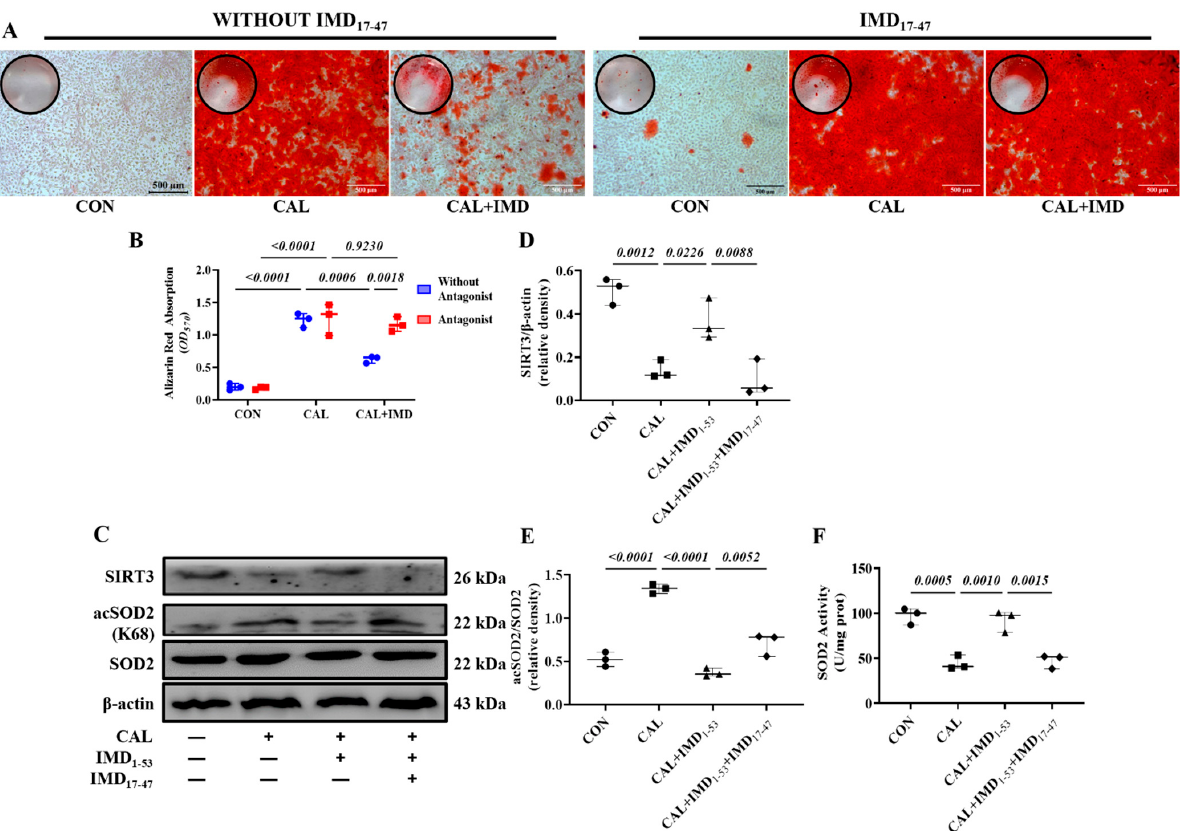
Figure 6. IMD upregulated Sirt3 via its receptor complex. ( A ) Alizarin red staining (positive staining: red) of rat VSMCs (Scale bar = 500 µ m), and ( B ) quantification ( n = 3). ( C ) Western blot analysis of protein levels of Sirt3, acetylation-SOD2 (K68) and SOD2 in rat VSMCs and quantification of ( D ) Sirt3 and ( E ) acetylation-SOD2 to SOD2 ratio ( n = 3). ( F ) SOD2 activity in rat VSMCs ( n = 3). CON (circles in ( D – F )): control VSMCs, CAL (squares in ( D – F )): calcification VSMCs, CAL + IMD 1-53 (triangles in ( D – F )): calcification VSMCs with IMD 1-53 treatment, CAL + IMD 1-53 + IMD 17-47 (diamonds in ( D – F )): calcification VSMCs with IMD 17-47 pretreatment and IMD 1-53 treatment. Without Antagonist (blue circles in (B)): VSMCs without IMD 17-47 pretreatment, Antagonist (red squares in (B): VSMCs with IMD 17-47 pretreatment. Data are mean ± SD.